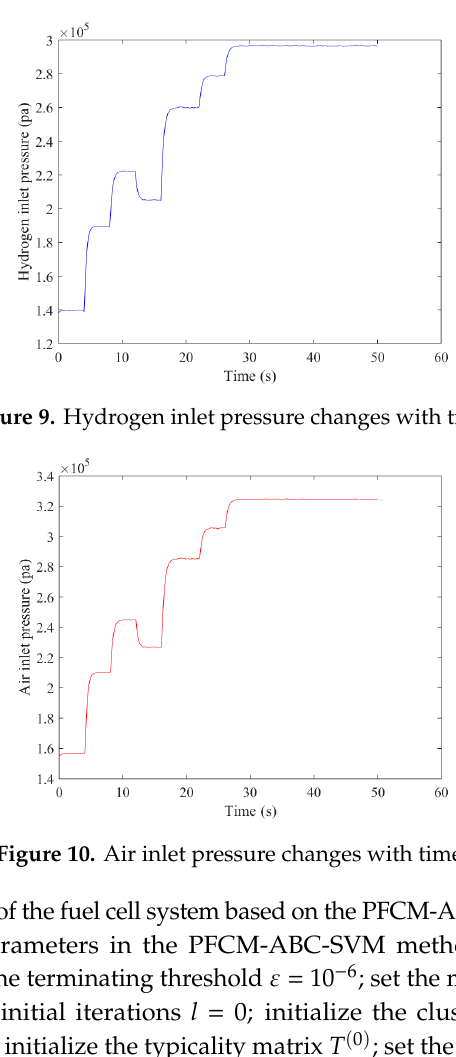
Figure 8. Compressor motor current changes with time.